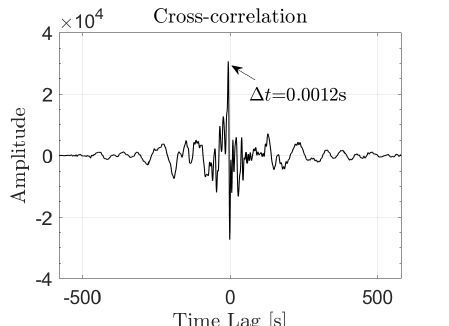
Figure 3. Cross-correlation between the two recorded signal corresponding to a 10 m